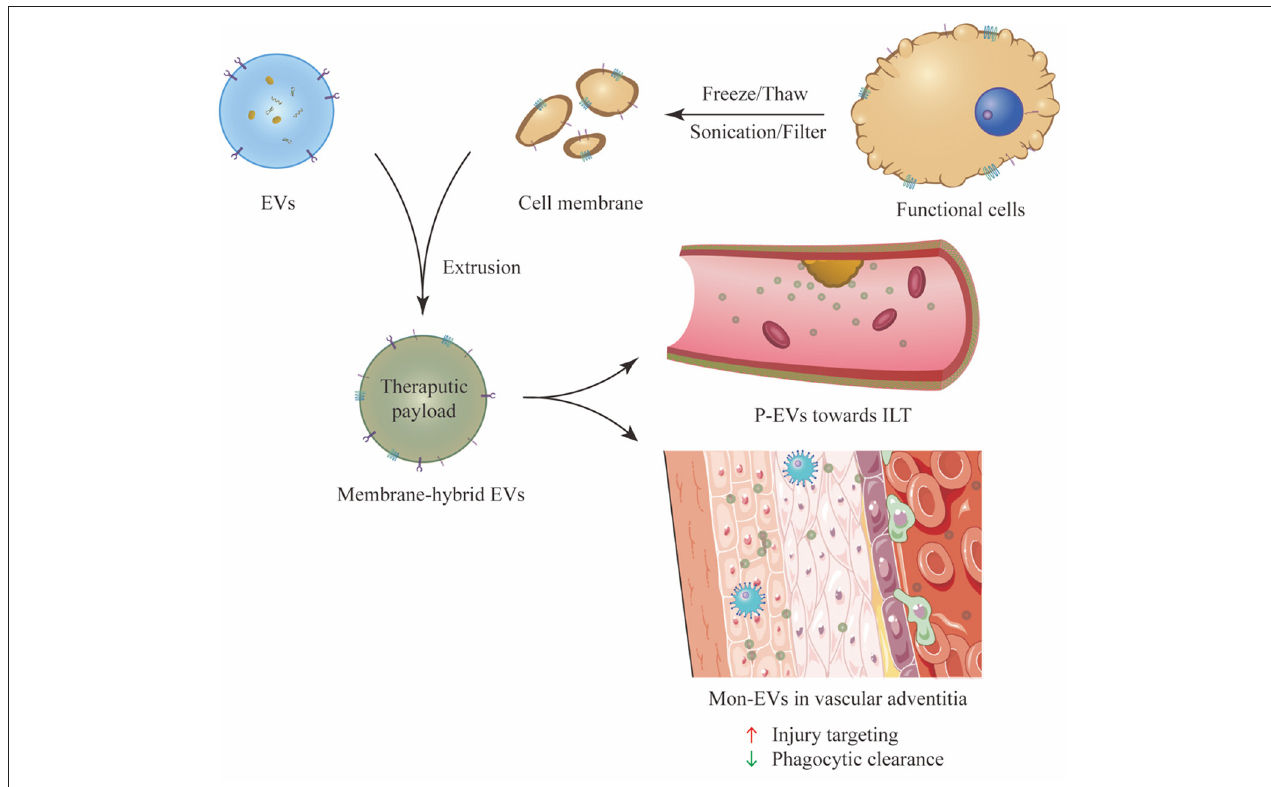
FIGURE 3 | Preparation and experimental application of membrane hybrid technology. P-EVs can actively target the ILT which adheres to the AAA wall, while Mon-EVs mainly accumulate in the adventitia of aortic wall and exert therapeutic effect. The membrane-hybridized EVs exhibit enhanced injury targeting ability and immune evasion ability. P-EV, platelet-membrane-hybrid EV; ILT, intraluminal thrombus; Mon-EVs, monocyte-membrane-hybrid